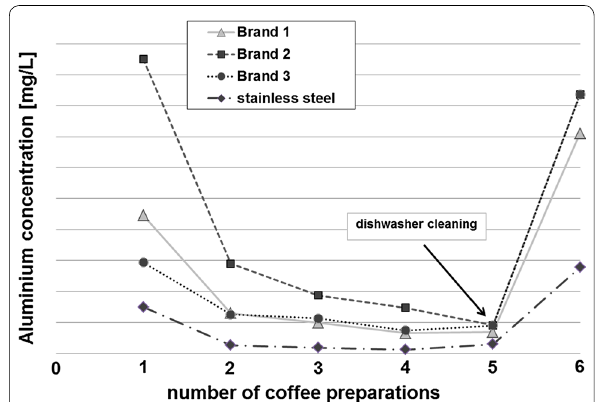
Fig. 3 Arithmetic means of aluminum concentration in coffee brewed 6 times in four different brands of moka pots. Pots from brands 1, 2, and 3 were made of aluminum and that from brand 4 was made of stainless steel. After the fifth brew the pots were